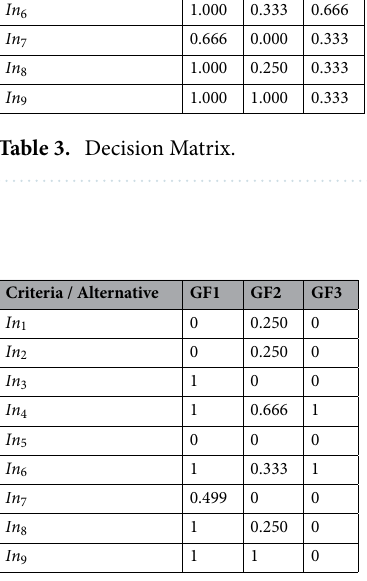
Table 4. Normalized Decision